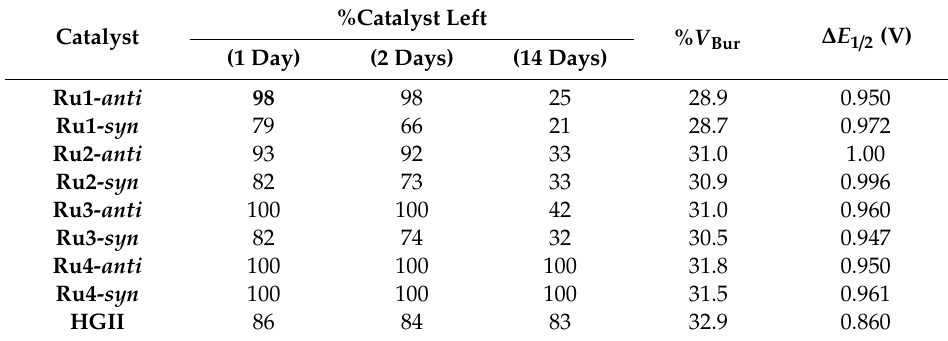
Table 1. Percentage of undecomposed complex, % V Bur values, and redox potentials for Ru1 – Ru4 1. Catalyst